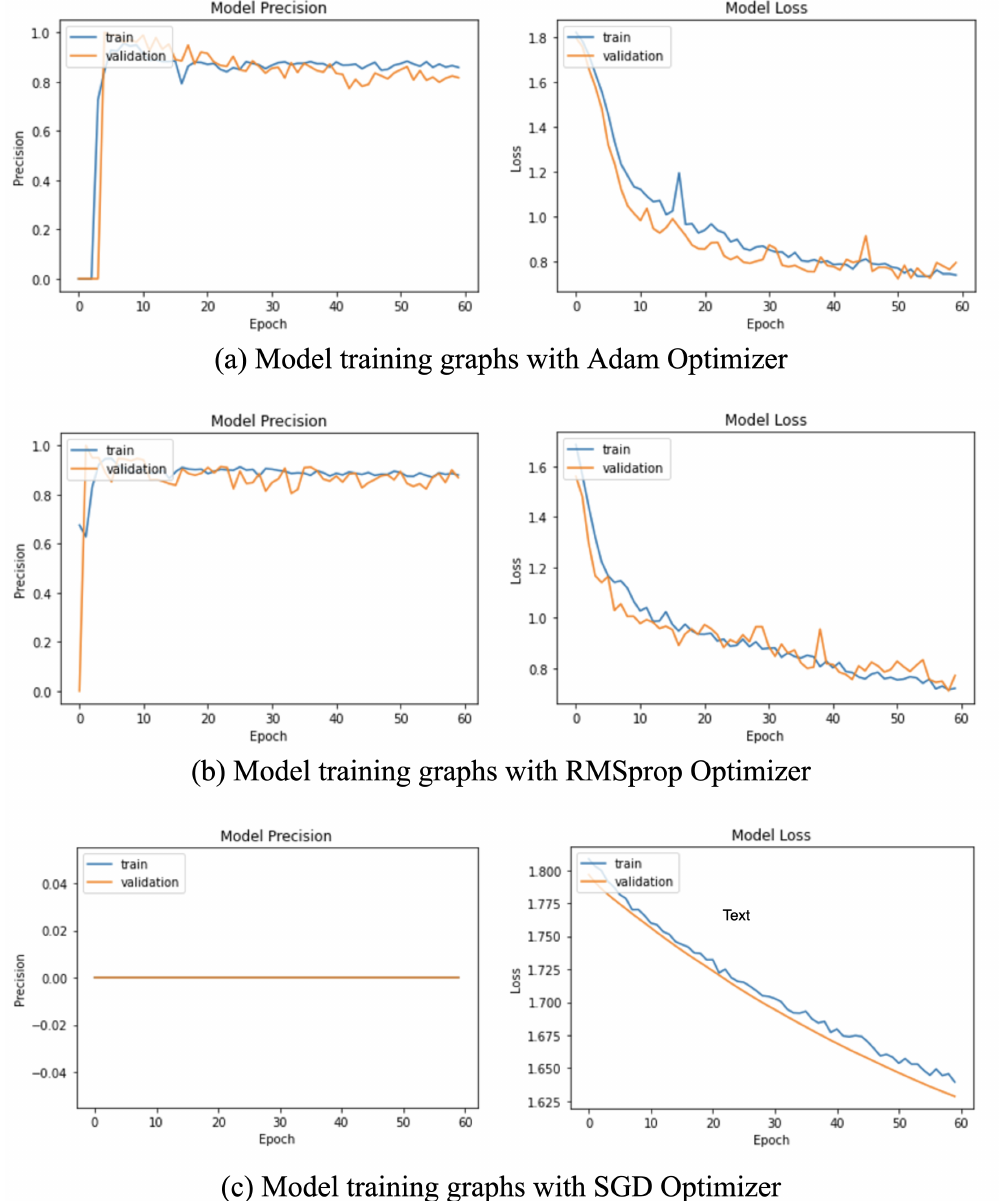
Figure 3. Model training graphs with: ( a ) Adam optimizer, ( b ) RMSprop optimizer, and ( c ) SGD